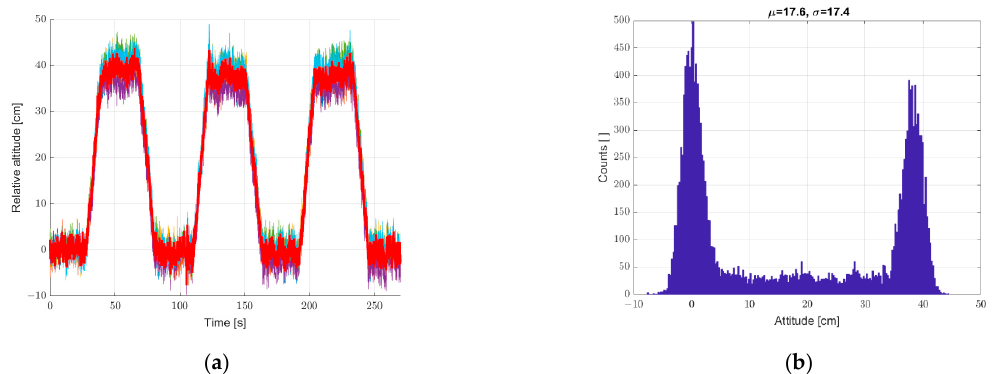
sensor array in motion.